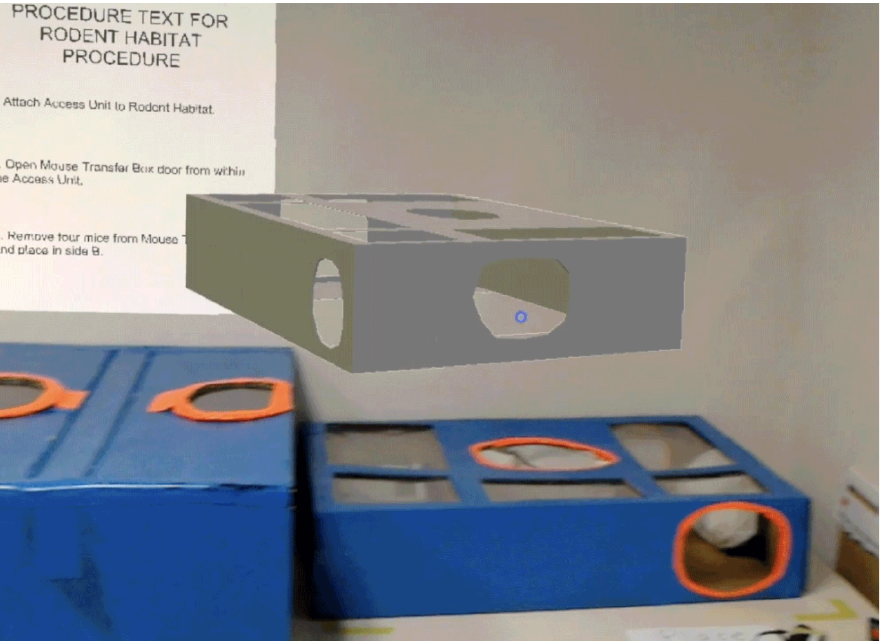
Figure 8. Holographic animations of the rodent research habitat showed users how to complete the